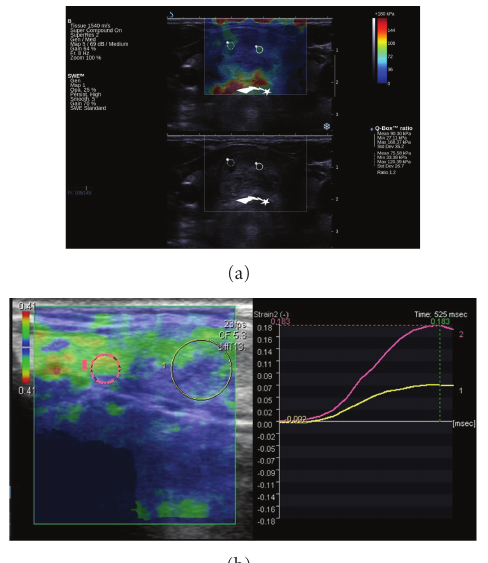
Figure 6: A benign thyroid nodule in a patient with solitary nodule in the thyroid isthmus that was suspicious on power Doppler ultrasound (not shown). The SSWE was true negative and the strain elastography was false positive for thyroid cancer. (a): The thyroid nodule in coronal plane on supersonic shear wave elastography (SSWE) (upper image) and B-mode ultrasound (lower image). The nodule is very soft on SSWE in contradiction to strain elastography (b). In the centre of the circular ROIs punctuate increased sti ff ness of small calcifications that are also visible on B-mode (lower image) is seen. Also artifacts of increased sti ff ness in the isthmus of the thyroid are visible. These artifacts are due to trachea (star arrow) and can be avoided with imaging in paracoronal plane of the nodule that does not incorporate the trachea. (b): The thyroid nodule (ROI 1-yellow) on strain elastography in sagittal plane, where the comparison with upper part of normal tissue of isthmus (ROI 2-pink) is possible. The strain color map (left) presents mostly sti ff nodule-thyroid nodule score 3. The time-strain graph (right) presents that the lesion is more than 2 times sti ff er than thyroid